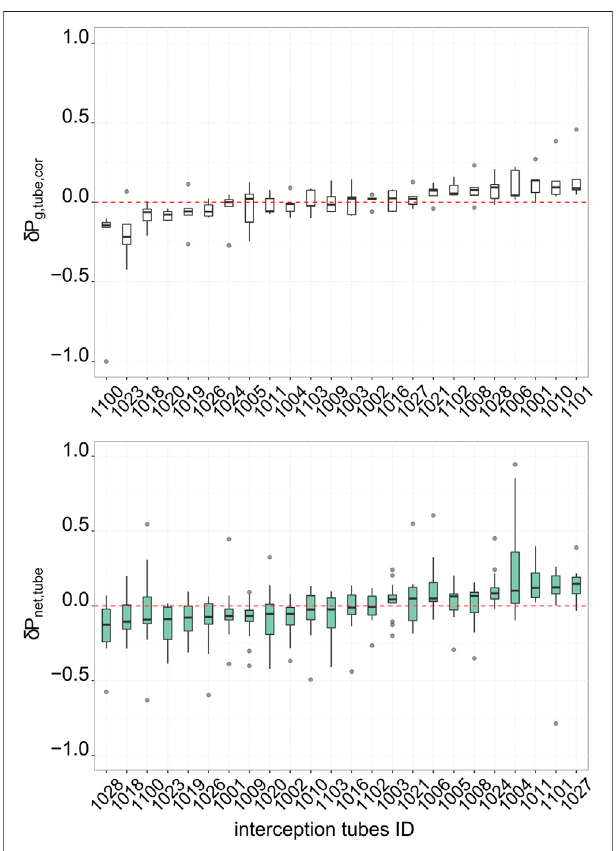
FIGURE 8 | Temporal stability of precipitation patterns based on the spatialdeviationoftheinterceptiontubemeasurementsin2019(April – August) for (top) uncovered period and (bottom) covered period. X axis indicates location identi fi cation, and Y axis gives the spatial deviation from the mean of the tubes ’ measurements for the particular location for all sampling weeks.